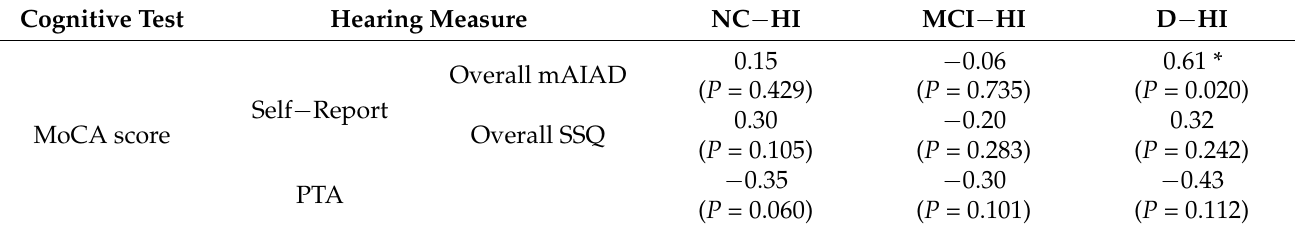
Table 4. Pearson correlations between the cognitive test score and the hearing measures. Cognitive Test